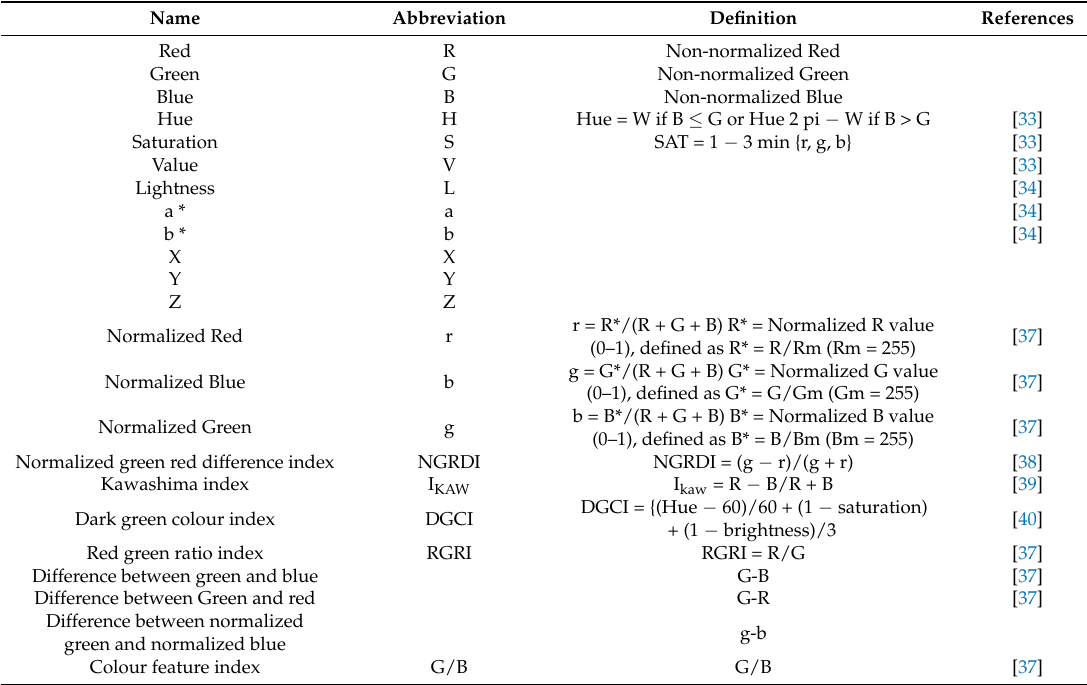
Table 2. Colour spaces and colour